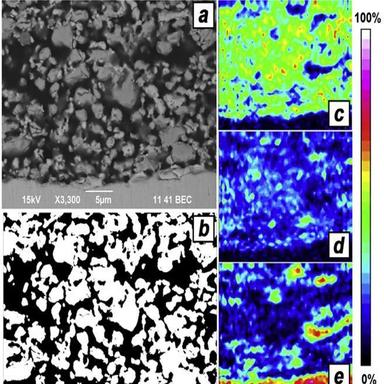
The SEM image of PYBCN/SDC composite deposited on SDC electrolyte (a) and results of the processing with ImageJ software (b). Right panel reflects cobalt (c), barium (d) and cerium (e) maps obtained by EDX. The scale bar indicates the corresponding atomic percent values.